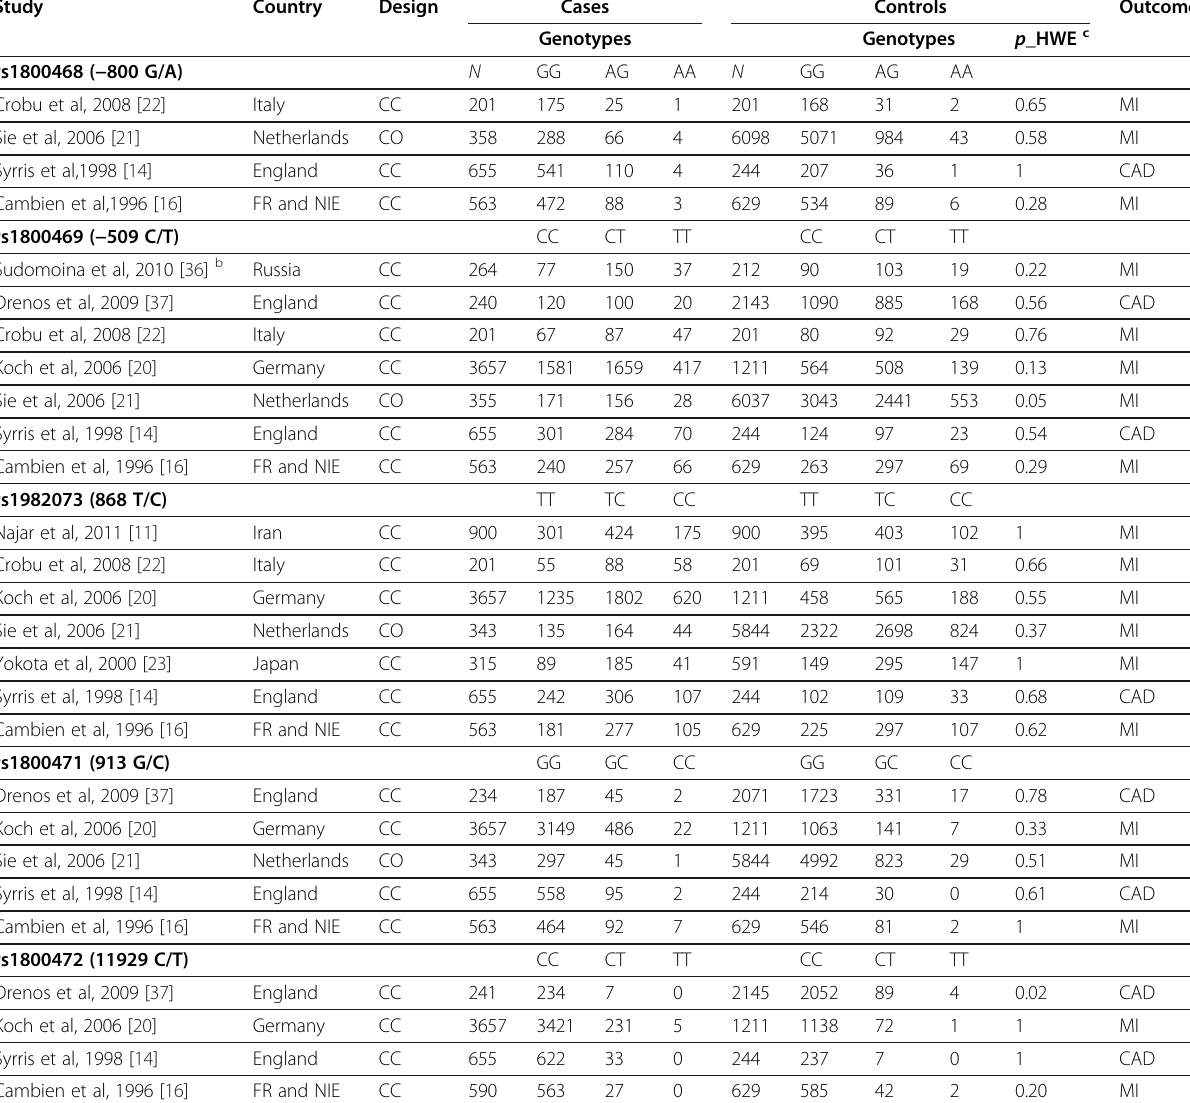
Table 1 Characteristics of studies included in the meta-analysis a